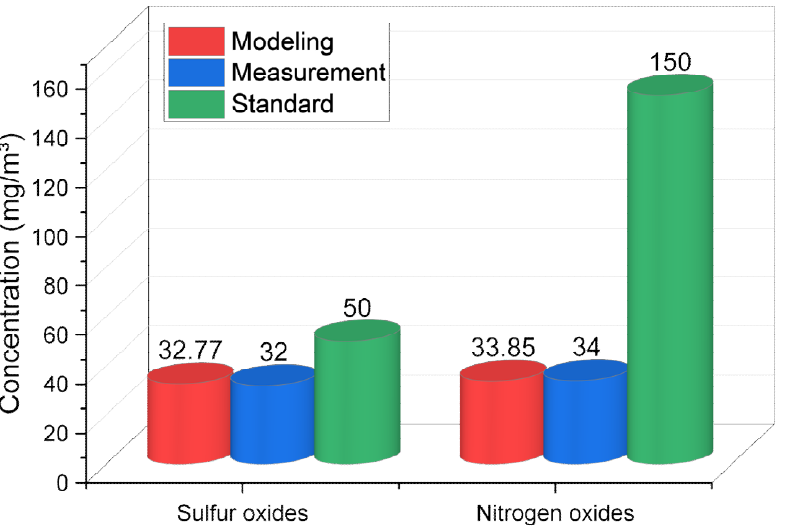
Figure 3. Concentration of sulfur oxides and nitrogen oxides in the exhaust.